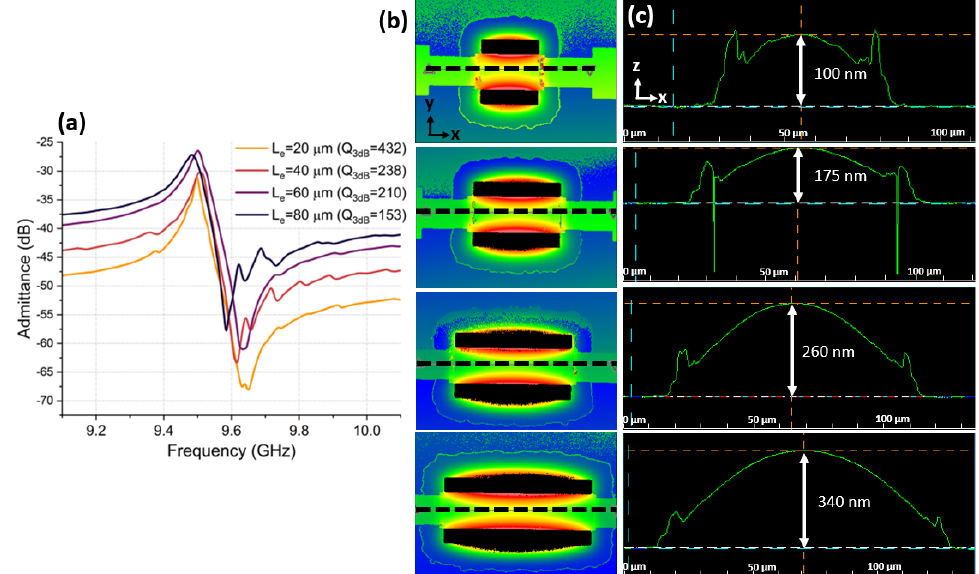
Figure 10. ( a )Measured Q 3 dB of CLMRs with different L e . ( b ) 3D ZYGO measurement of top surface view of CLMRs with different L e . ( c ) 2D ZYGO measurement of out-of-plane bending amplitude for each L e .